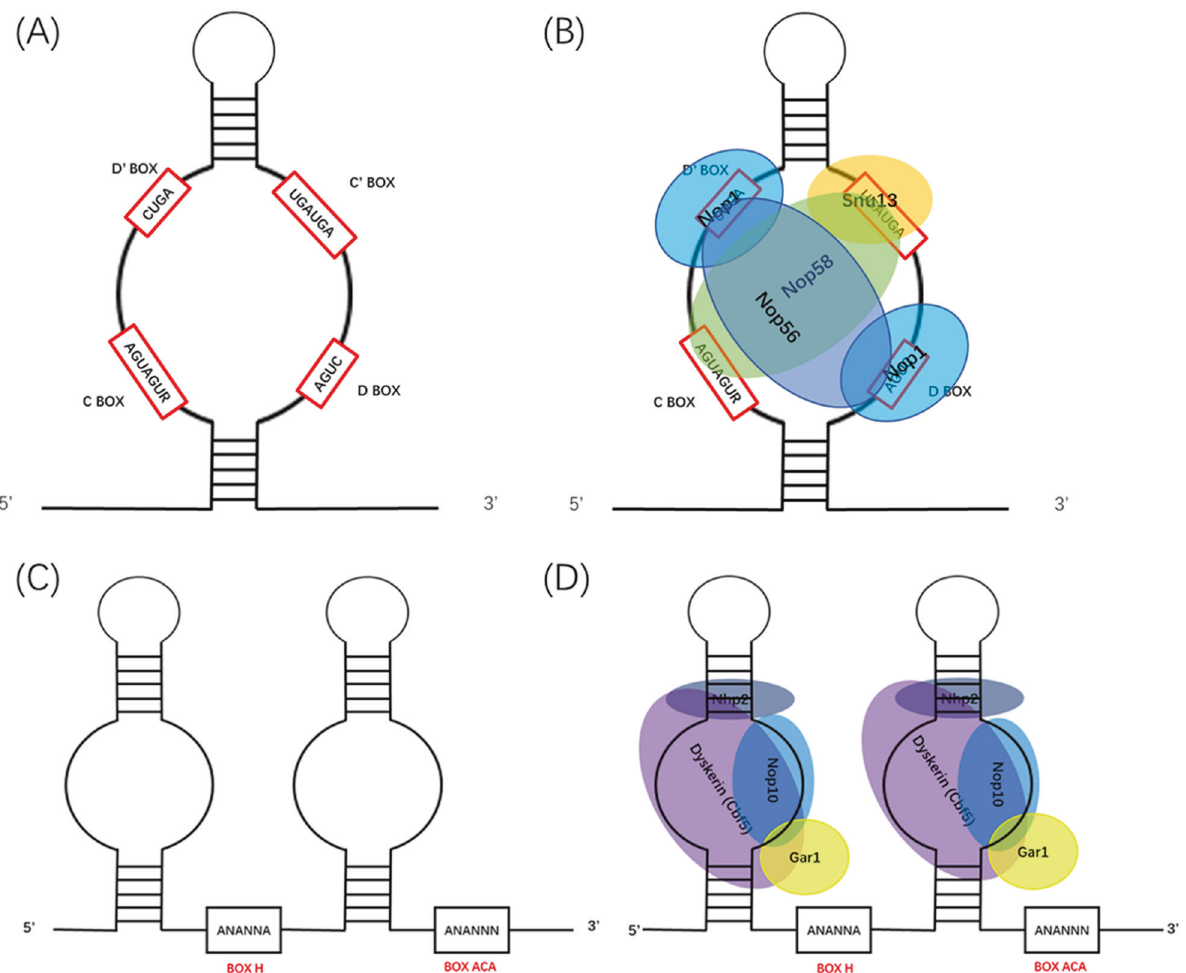
Fig. 2 Structures of snoRNAs and snoRNPs. The structure of C/D box snoRNAs A , C/D box snoRNPs B , H/ACA box snoRNAs C , and H/ACA box snoRNPs D .